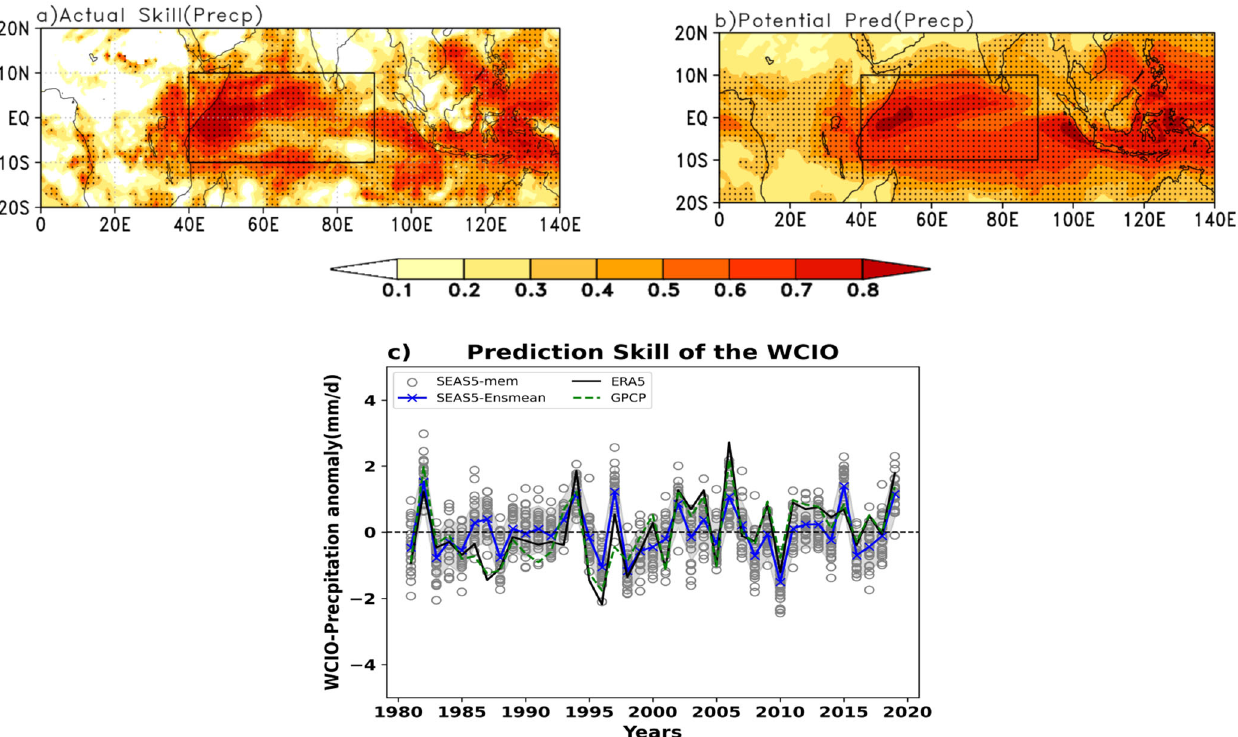
Fig. 5 Prediction skill of the WCIO precipitation anomalies. a Actual Prediction skill of the early winter (November – December; ND) precipitation anomalies over the tropical western-central Indian Ocean (WCIO) [40:90°E; 10°S:10°N] region; ( b ) Potential Predictability of the WCIO precipitation anomalies. Stippling denotes statistical signi fi cance at 95% con fi dence level; ( c ) Prediction skill of the early winter (ND) precipitation anomalies over the WCIO region with respect to ERA5(GPCP) is 0.72(0.66). Grey circles show each ensemble member for ECMWF- SEAS5, while blue line is the SEAS5 ensemble mean, black line represents ERA5 and green dashed line is for GPCP. Light grey shading is the ensemble mean spread based on its 1-sigma